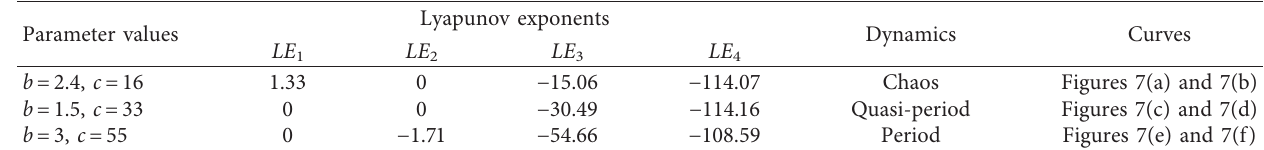
Table 1: Lyapunov exponents of the proposed chaotic system with varying parameters under a � 112. Parameter